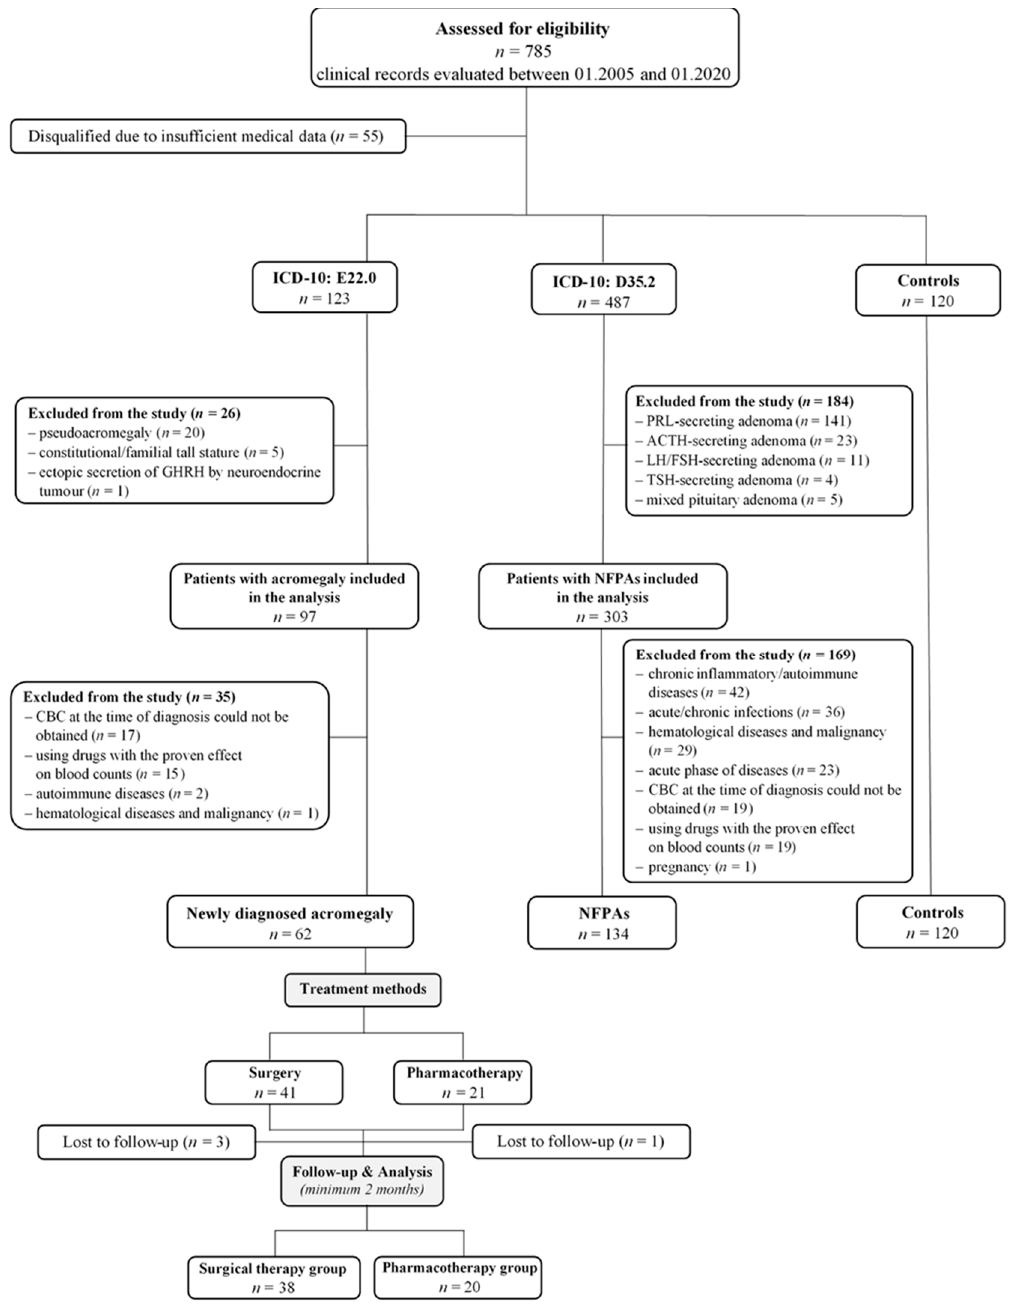
Figure 1. Flow chart of the study. ICD-10—International Classification of Diseases revision 10; CBC—complete blood count; NFPA—non-functioning pituitary adenoma; GHRH—growth hormone-releasing hormone; PRL—prolactin; ACTH—adrenocorticotropic hormone; LH—luteinizing hormone; FSH—follicle-stimulating hormone; TSH—thyroid-stimulating hormone.